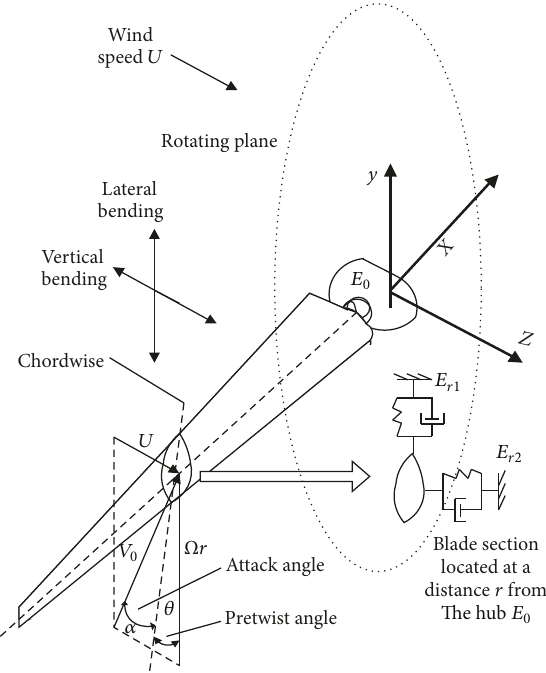
Figure 1: The blade structure and coordinate